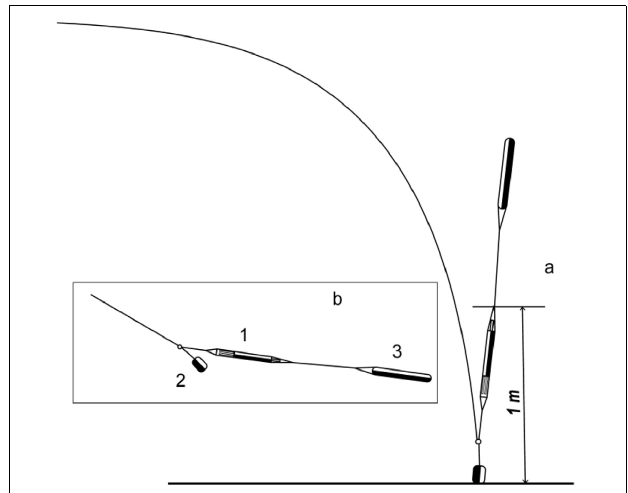
FIGURE 3 | Arrangement of the profiling system, consisting of (1) CTD48Mc (Sea and Sun Technology), (2) load and (3) float, linked by pieces of rope. (a) Configuration when CTD reaches the bottom, (b) configuration during